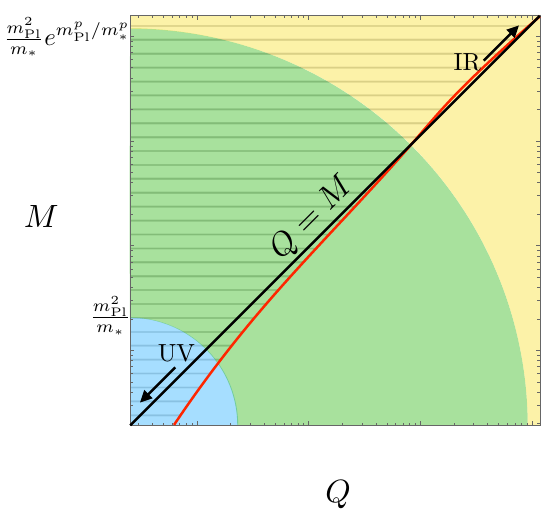
Figure 2 . In rare examples of nonsupersymmetric theories with a large number of species and nonminimal couplings in a specific Planckian range, the beta function drives the running of the F 4 Wilson coefficient to negative values in the exponentially deep IR (yellow). In that region, the Q/M ratio for extremal black holes acquires a negative correction. Nonetheless, we expect that in healthy theories in the threshold region (green), the finite corrections associated with sub-Planckian states in the UV completion nonetheless yield a net positive contribution to Q/M , so that all extremal black holes — including those with exponentially large masses — are able to decay, preserving the